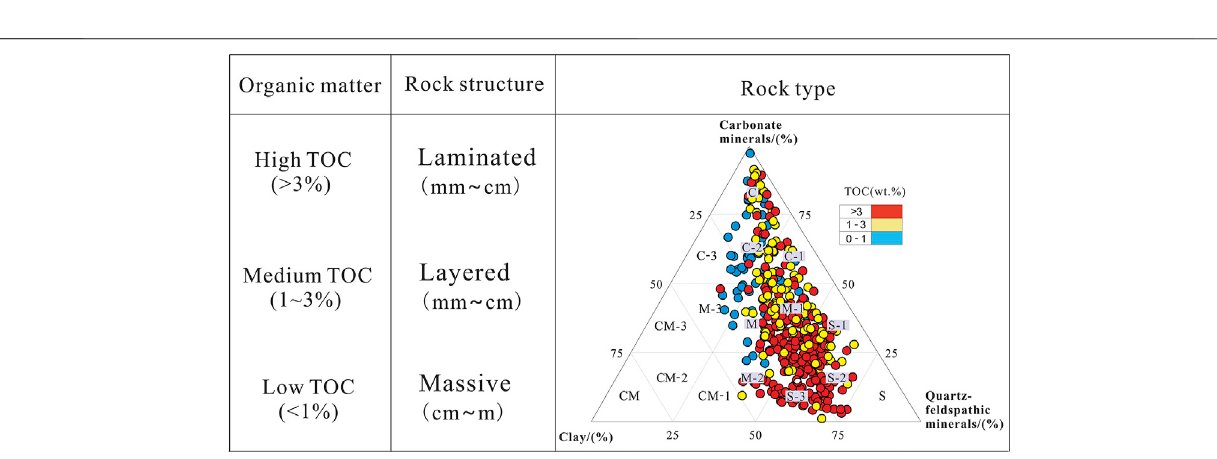
Frontiers in Earth Science |